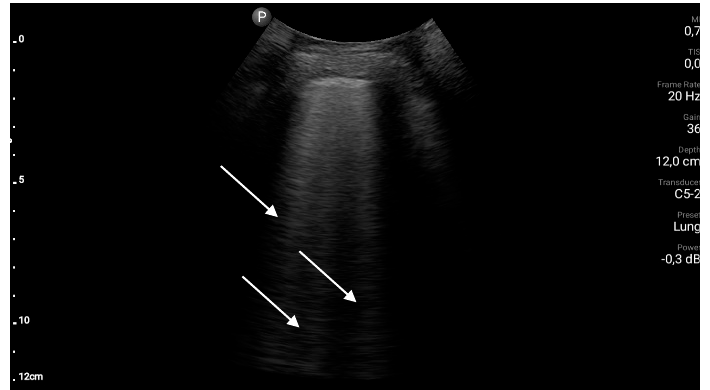
Figure 3. Normal pleural line (red arrow) and A-line artefacts (white arrows).